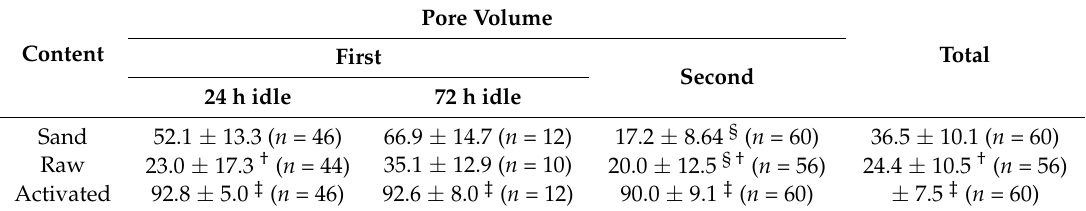
Figure 6. E. coli removal efficiencies from large columns during 30 days of flushing with a flow rate of 33.3 mL (1.35 cm)/min. Table 2. Removal efficiency (average% ± standard deviation) of E. coli in large column experiments during 30 days of intermittent flushing in duplicate columns of each treatment.